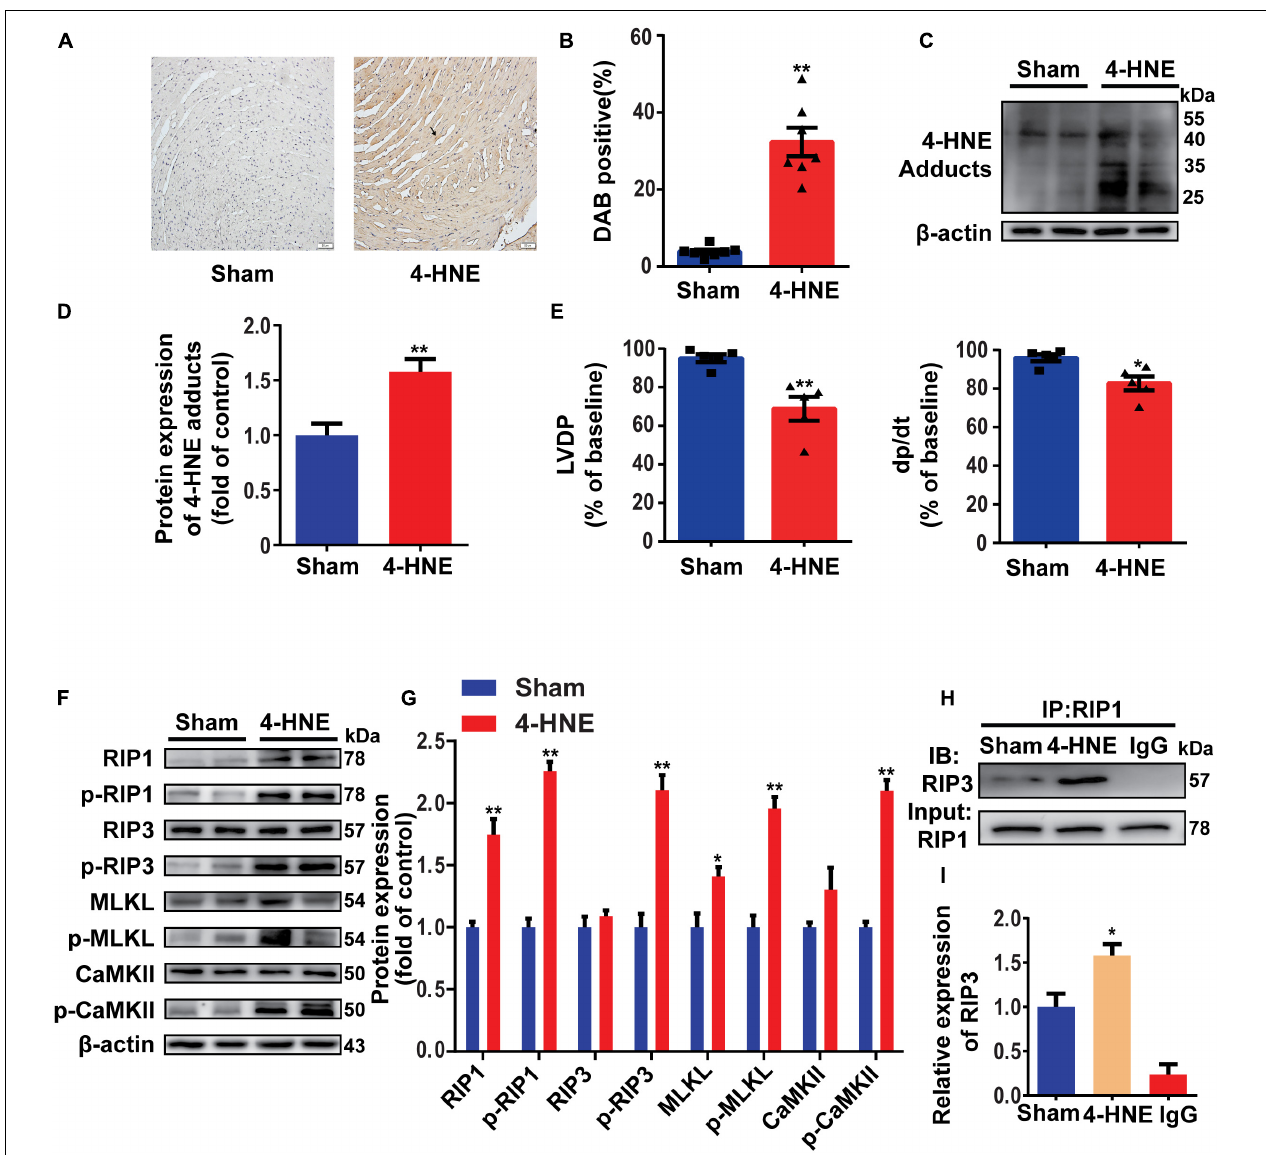
FIGURE 3 | 4-Hydroxy-2-non-enal induces myocardial necroptosis in Langendorff-perfused hearts. (A,B) Representative immunohistochemical staining and analysis of 4-HNE expression in mouse hearts ( n = 7). Scale bar = 50 µ m. (C,D) Representative Western blots and relative expression of 4-HNE adducts in mouse hearts ( n = 6). (E) Cardiac function was evaluated by left ventricular developed pressure (LVDP) and left ventricular pressure rising rate (dp/dt) compared to the baseline ( n = 5). (F,G) Representative Western blots and relative expression of receptor-interacting serine/threonine-protein kinase 1 (RIP1), p-RIP1, RIP3, p-RIP3, MLKL, p-MLKL, Ca 2 + /CaMKII, p-CaMKII in mouse hearts ( n = 6). (H,I) Co-immunoprecipitation using anti-RIP1 antibody indicating the combination between RIP1 and RIP3 ( n = 3). * p < 0.05 vs. sham group, ** p < 0.01 vs. sham